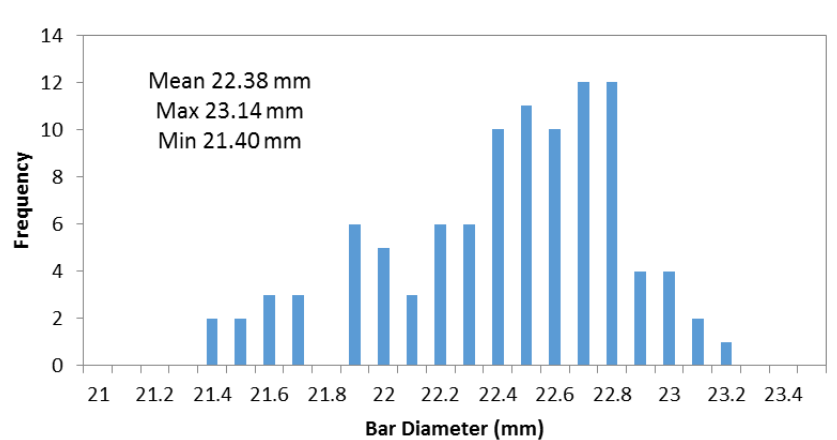
Figure 1. Post-swaged RR1000 bar.